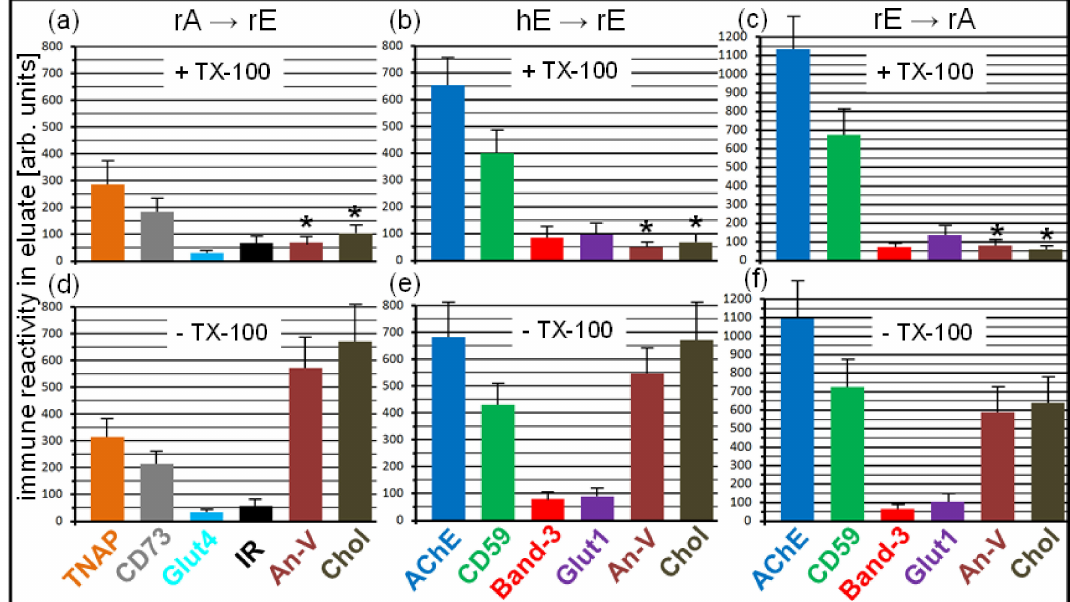
Figure 10. Analysis of the chip eluate for micelle-like GPI-AP complexes released from the donor PM upon blocked transfer of full-length GPI-APs to acceptor PM at various combinations. Rat adipocyte ( a , d ), human erythrocyte ( b , e ), and rat erythrocyte ( c , f ) donor PM were injected into chips with rat erythrocyte ( a , b , d , e ) or rat adipocyte ( c , f ) acceptor PM as described for Figure 9. Following injection of 100 µ L of serum from obese ZDF rats (diluted five-fold with buffer) together with 100 µ M Pha, the chips were incubated until 4800 s at 37 ◦ C at flow rate 0. Following injection of 100 µ L of EGTA/NaCl at a flow rate of 60 µ L/min and then of 400 µ L of washing buffer at the same flow rate, the eluate from the chip channels was collected from 4900 to 5300 s and then centrifuged (100,000 × g , 1 h, 4 ◦ C). The supernatants were removed, and halves incubated in the absence ( d – f ) or presence ( a – c ) of TX-100 (0.1%) for 1 h at 30 ◦ C and then with α -toxin coupled to Sepharose beads as described in the Methods section for 20 h at 4 ◦ C (head-over rotation). The mixtures were centrifuged (10,000 × g , 5 min, 4 ◦ C). The pellets were washed three times by suspending in washing buffer and recentrifugation. The final pellets were suspended in the same volume of two-fold Laemmli sample buffer and heated (5 min, 65 ◦ C). Following centrifugation (10,000 × g , 5 min, 25 ◦ C), the supernatants were assayed for the presence of GPI-APs and transmembrane proteins by dot blotting with antibodies against TNAP, CD73, AChE, CD59, Glut4, Glut1, Band-3 and Annexin-V as described in the Methods section. Portions of the washed and Laemmli-extracted α -toxin Sepharose beads were determined for cholesterol. The immune reactivities and cholesterol amounts (arb. units) are given as means ± SD (four distinct transfer incubations and chip elutions each) with dot blotting in triplicate each upon normalization by subtraction of unspecific signals generated in the absence of antibody and Sepharose beads, respectively (* p ≤ 0.01 vs. incubation in the absence of